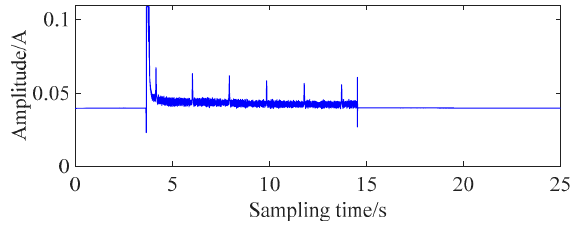
Figure 8. Signal of trash-in-gear fault.